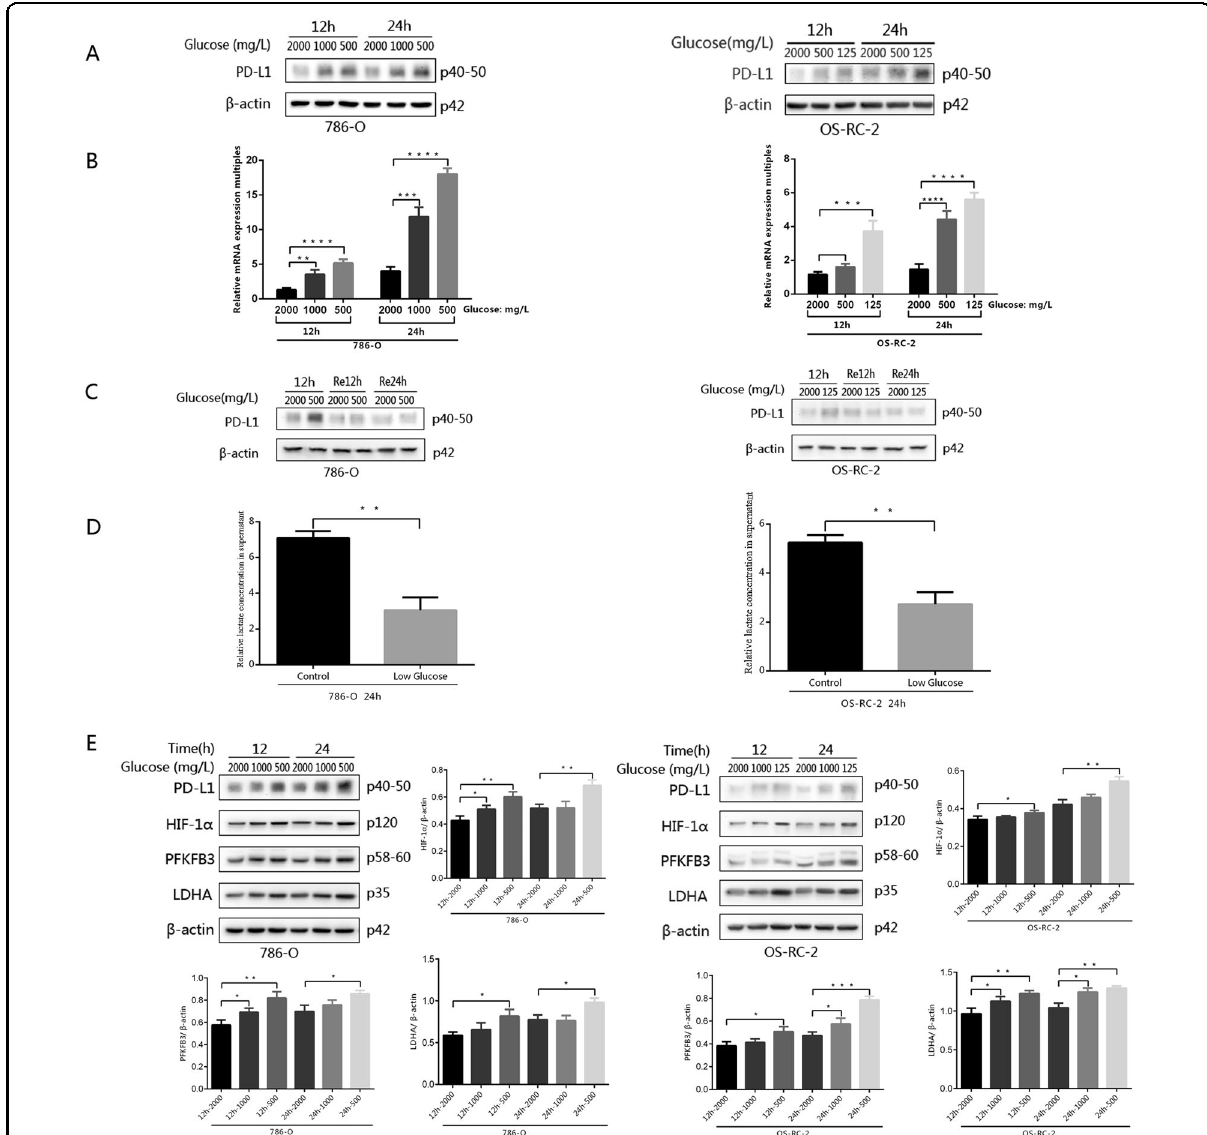
Fig. 2 Expression levels of glucose metabolism-related enzymes, products and PD-L1 under different intervention conditions. A The expression of PD-L1 in the 786-O and OS-RC-2 cell lines was detected by western blotting after 12 or 24 h of culture under low-glucose conditions. B The expression of PD-L1 in the 786-O and OS-RC-2 cell lines was detected by RT-qPCR after 12 or 24 h of culture under low-glucose conditions. C Western blotting was used to detect changes in PD-L1 expression in the 786-O and OS-RC-2 cell lines after 12 h of low-glucose culture followed by culture medium replacement with that of normal glucose concentration. D Lactic acid (LD) production in the two cell lines were different under low- glucose conditions. E Western blotting was used to detect the expression differences in HIF-1 α , PFKFB3 and LDHA, key enzymes in glycolysis. Independent experiments were performed in triplicate. Data are expressed as mean ± SD. * P < 0.05, ** P < 0.01, *** P < 0.001 and **** P <